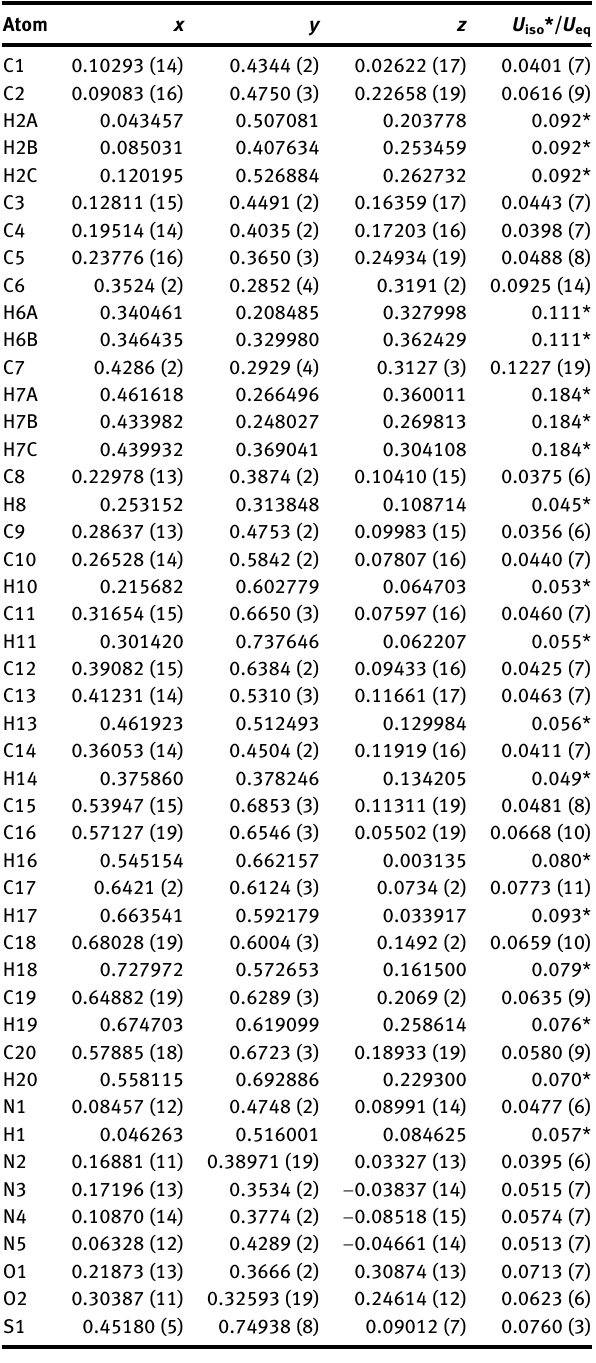
Table  : Fractional atomic coordinates and isotropic or equivalent isotropic displacement parameters (Å 